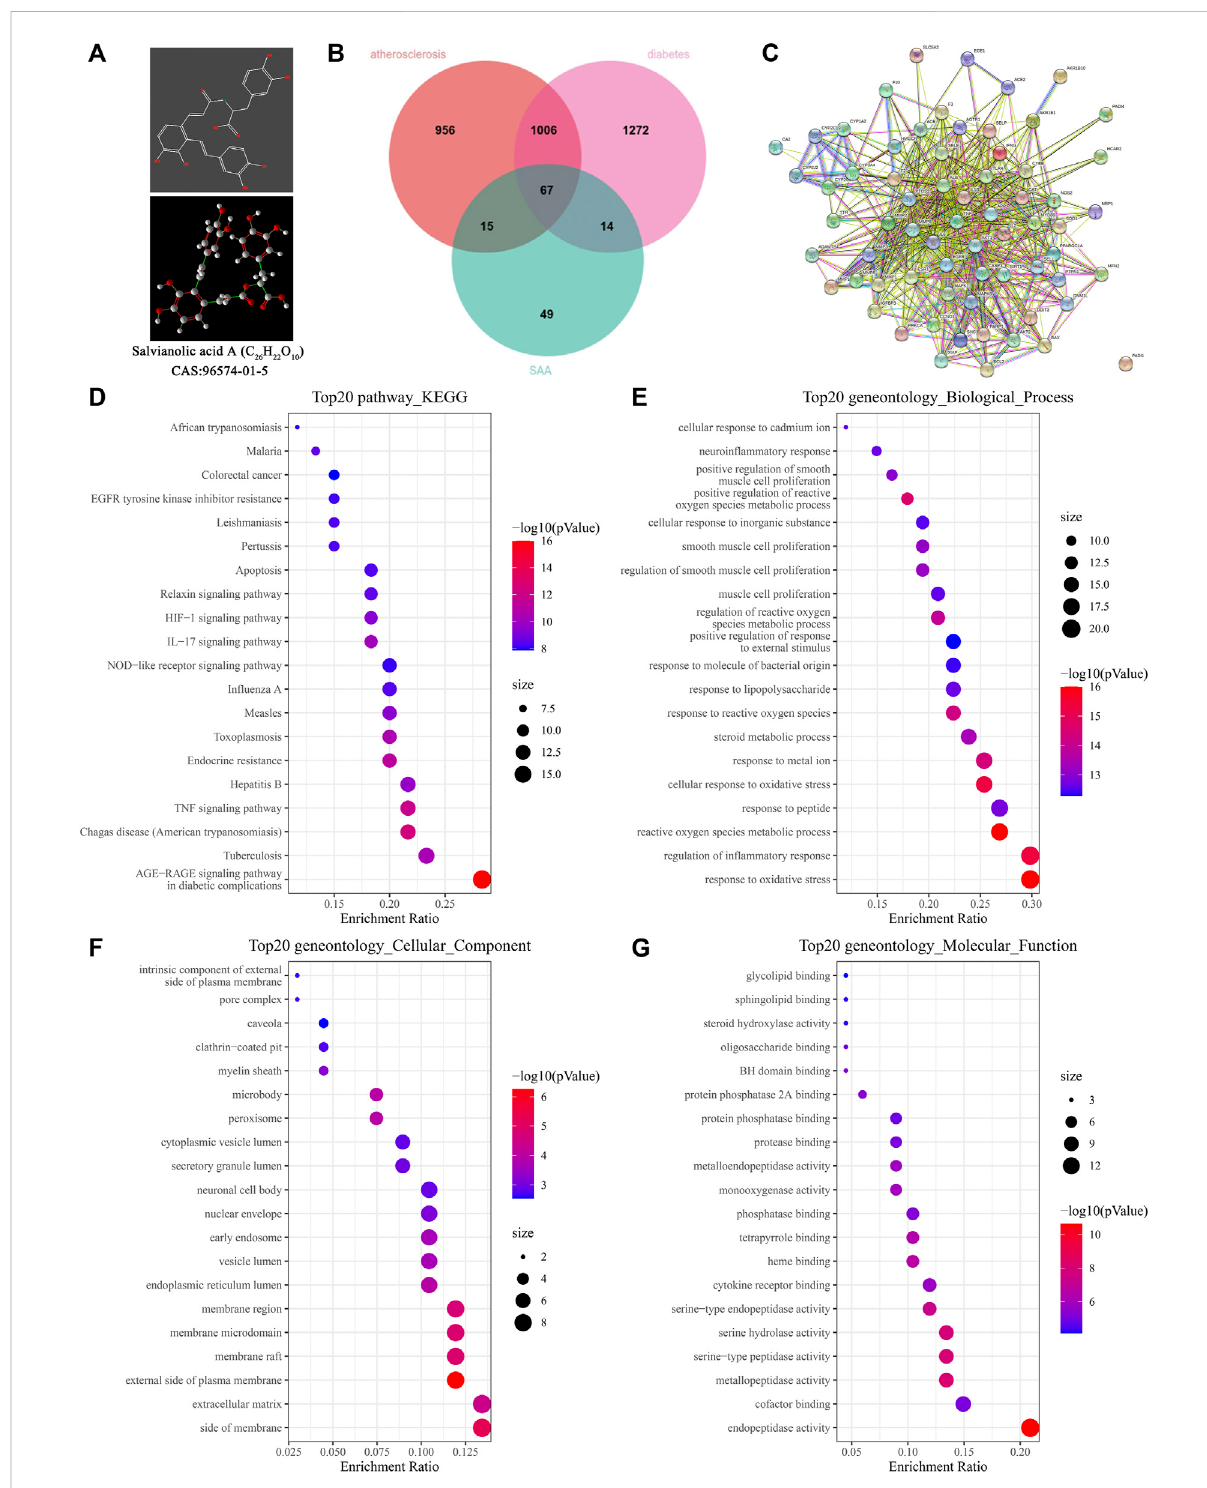
Network pharmacology analysis of SAA indiabetic atherosclerosis. (A) The chemical structure of SAA. (B) The overlapping targetsof diabetic AS and SAA. (C) The interaction network of the overlapping targets. (D) KEGG enrichment analysis for the overlapping targets. (E – G) GO analysis for the overlapping